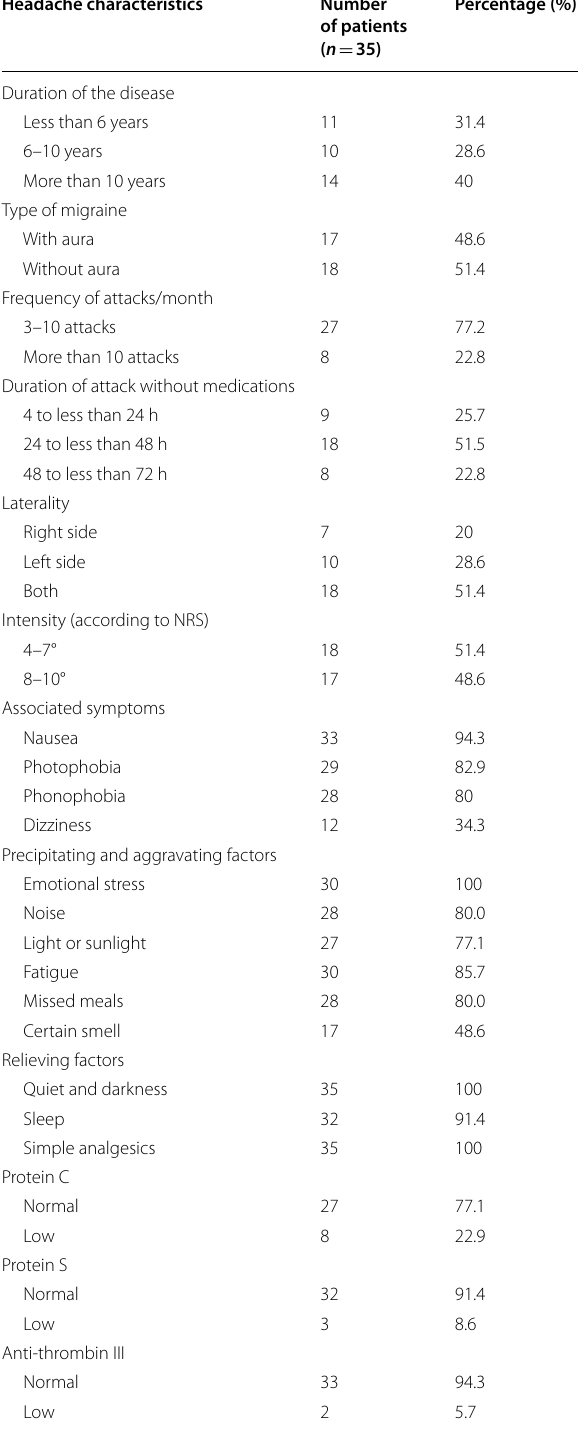
Table 1 Clinical and laboratory characteristics of